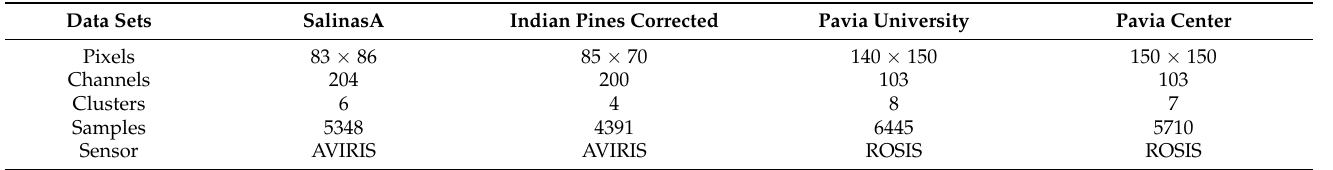
Table 1. Summary of SalinasA, Indian Pines, Pavia University, and Pavia Center data sets. Data Sets